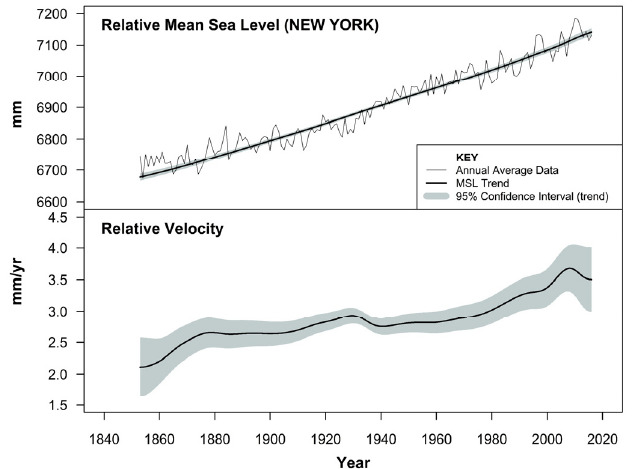
Figure 2. Estimated mean sea level and associated velocity from the Battery Park (New York) tide gauge record.